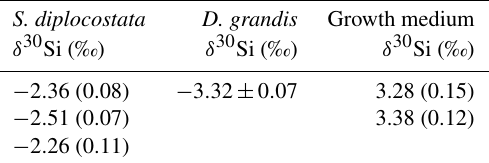
Table 1. Silicon isotopic composition of choanoflagellates and growth media. Numbers in parentheses show 1SD internal errors; ± shows external error from biological